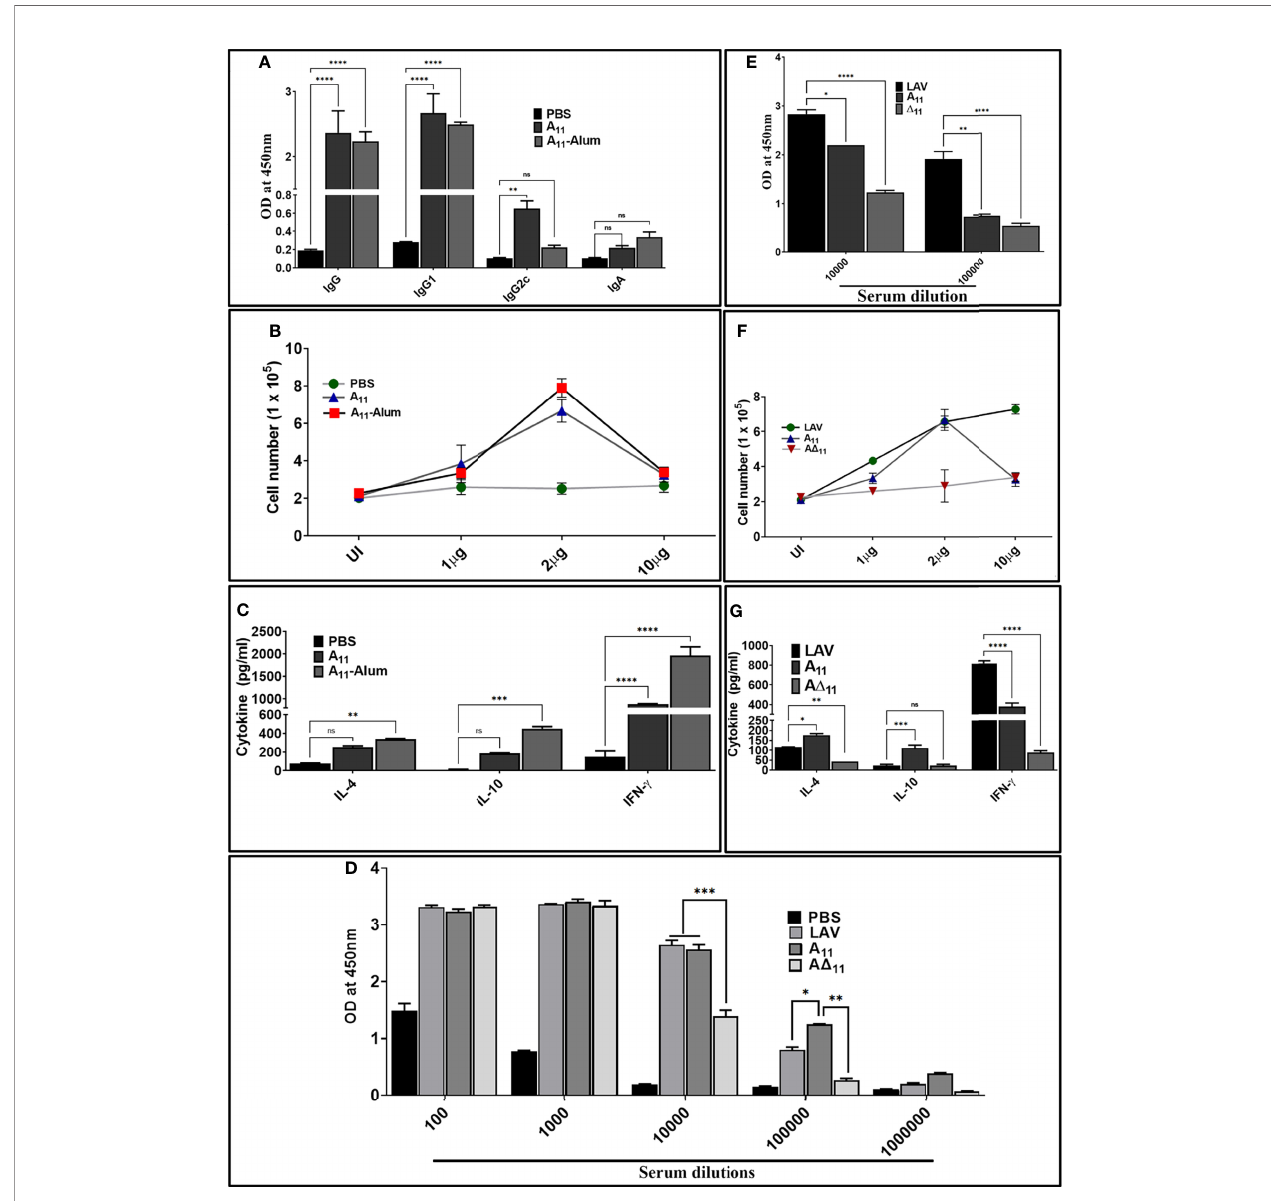
A 11 and A Δ 11 . Lymphocytes isolated at day 28 from animals immunized with LAV-Alum were stimulated with A 11 and A Δ 11 for 72h and analysed for proliferation and cytokines in the culture supernatant were determined as described above. All data are representative of three independent experiments. Signi fi cant differences